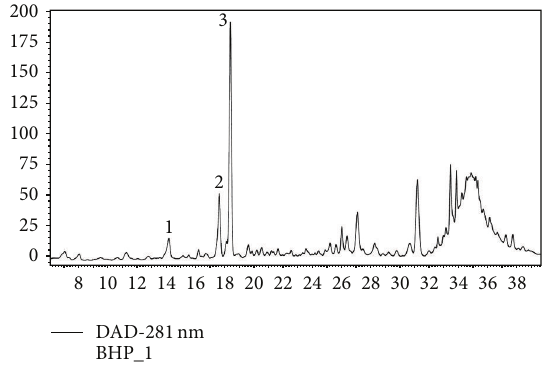
Figure 2: HPLC profile of polyphenols detected separated on Protect-1 C18 column and detected at 280 nm. 1: vanillic acid- derivative, 2: catechin, and 3: naringenin-diglucoside.